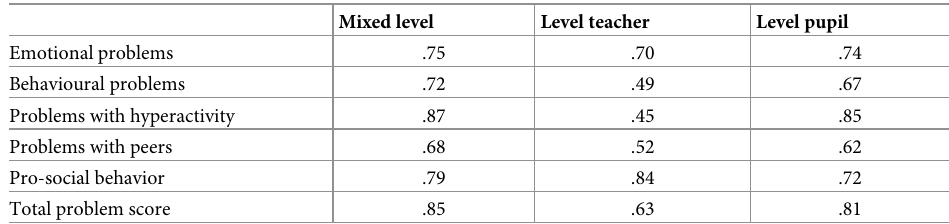
Table 1. Reliability of the SDQ-L scales for mixed, teacher and pupil